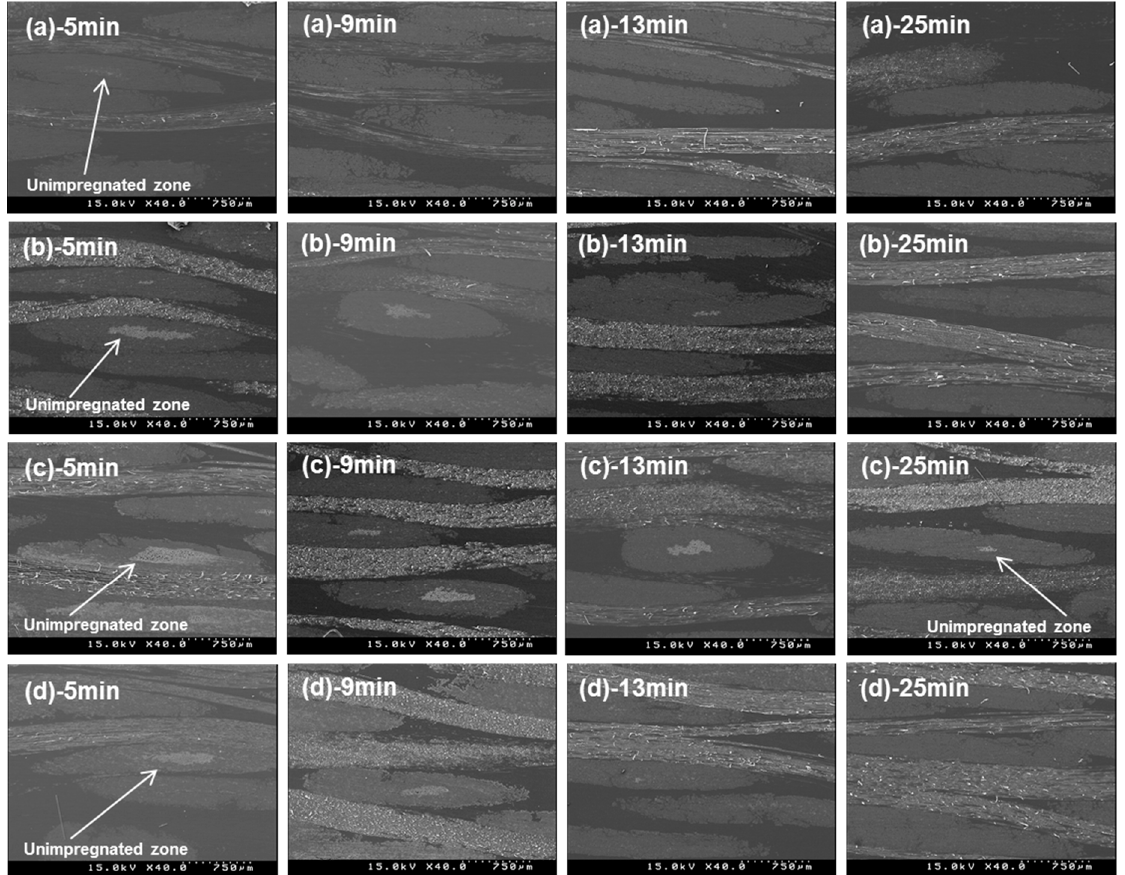
Figure 9. Cross-section SEM images in accordance with the pressure rising time in each film stacking type; ( a ) LV-type; ( b ) MV-type; ( c ) HV-type; ( d ) CV-type.